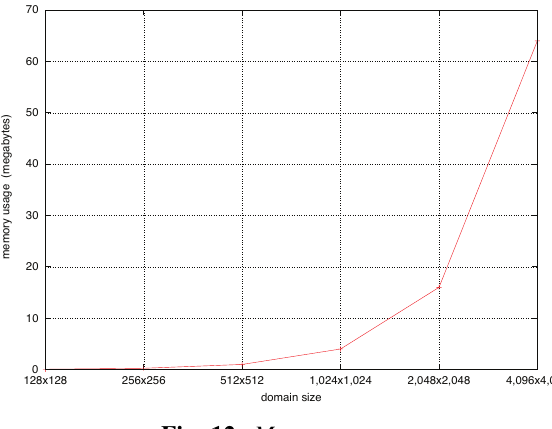
Fig. 12: Memory usage. The tardiness-applied-test starts running using the domain size 128 128 and changes this value until it reaches 2 , 048 × × 2 , 048 , when it discovers that this domain size is infeasible because tardiness is greater than 1 . The test then chooses the 1 , 024 ) for the domain size and last suitable value ( 1 , 024 × keeps on using while tardiness ranges from 0 . 8 to 1 . The test uses this range to avoid constant domain size switching (e.g., 1 , 024 to 2 , 048 2 , 048 , back and forth). On the from 1 , 024 × × other hand, when tardiness is below 0 . 8 , the test decreases the 512 domain size to the previous suitable value (e.g., 512 ×